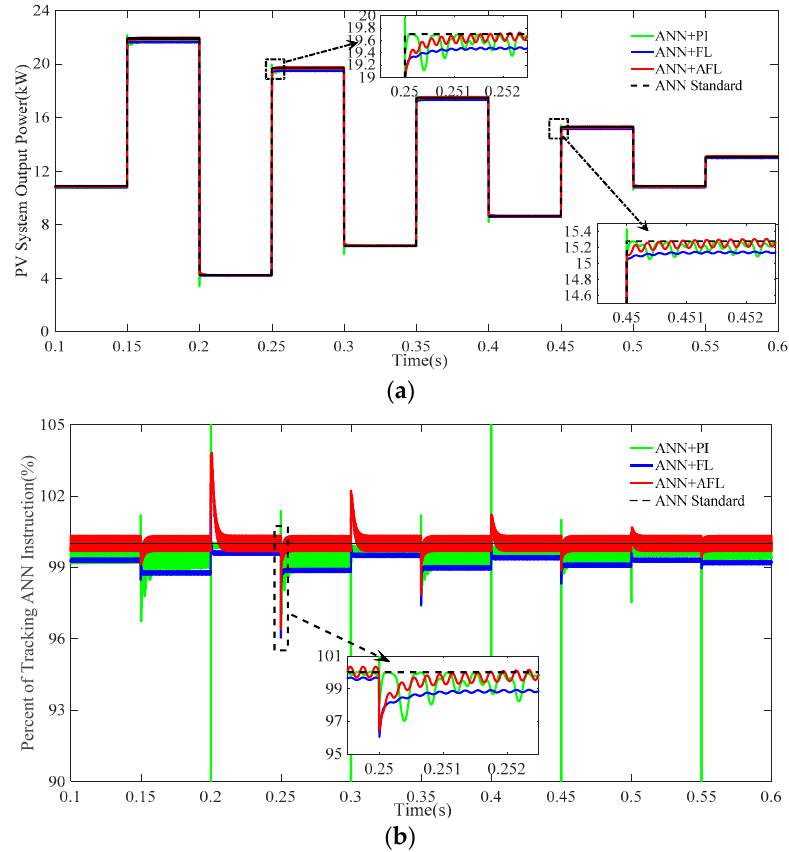
Figure 17. Output powers of the PV system with ANN and different DC/DC control strategies: ( a ) Output power (overall); ( b ) Output of each method divided by ANN reference.